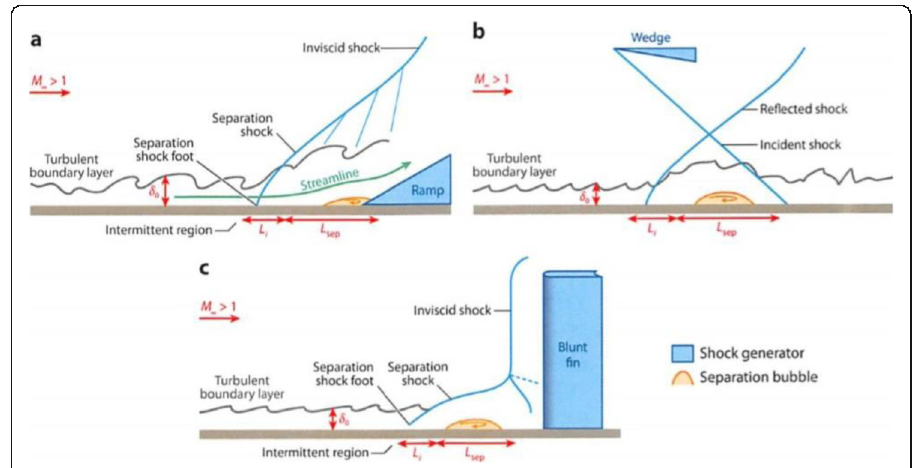
Fig. 1 Schematic diagrams of overall flow features for three shock wave boundary layer interaction arrangements from Clemens and Narayanaswamy [3]. a Compression ramp. b Wedge. c Blunt